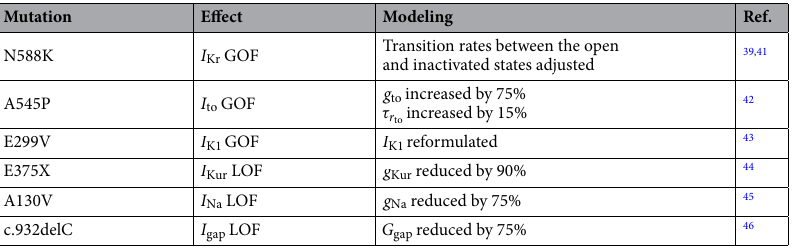
Table 2. Summary of how each of the selected mutations that have been linked to AF are represented in the LA and PV models. Here, GOF refers to gain-of-function mutations, and LOF refers to loss-of-function mutations. Complete mathematical specifications of each of these modified currents are given in the Supplementary